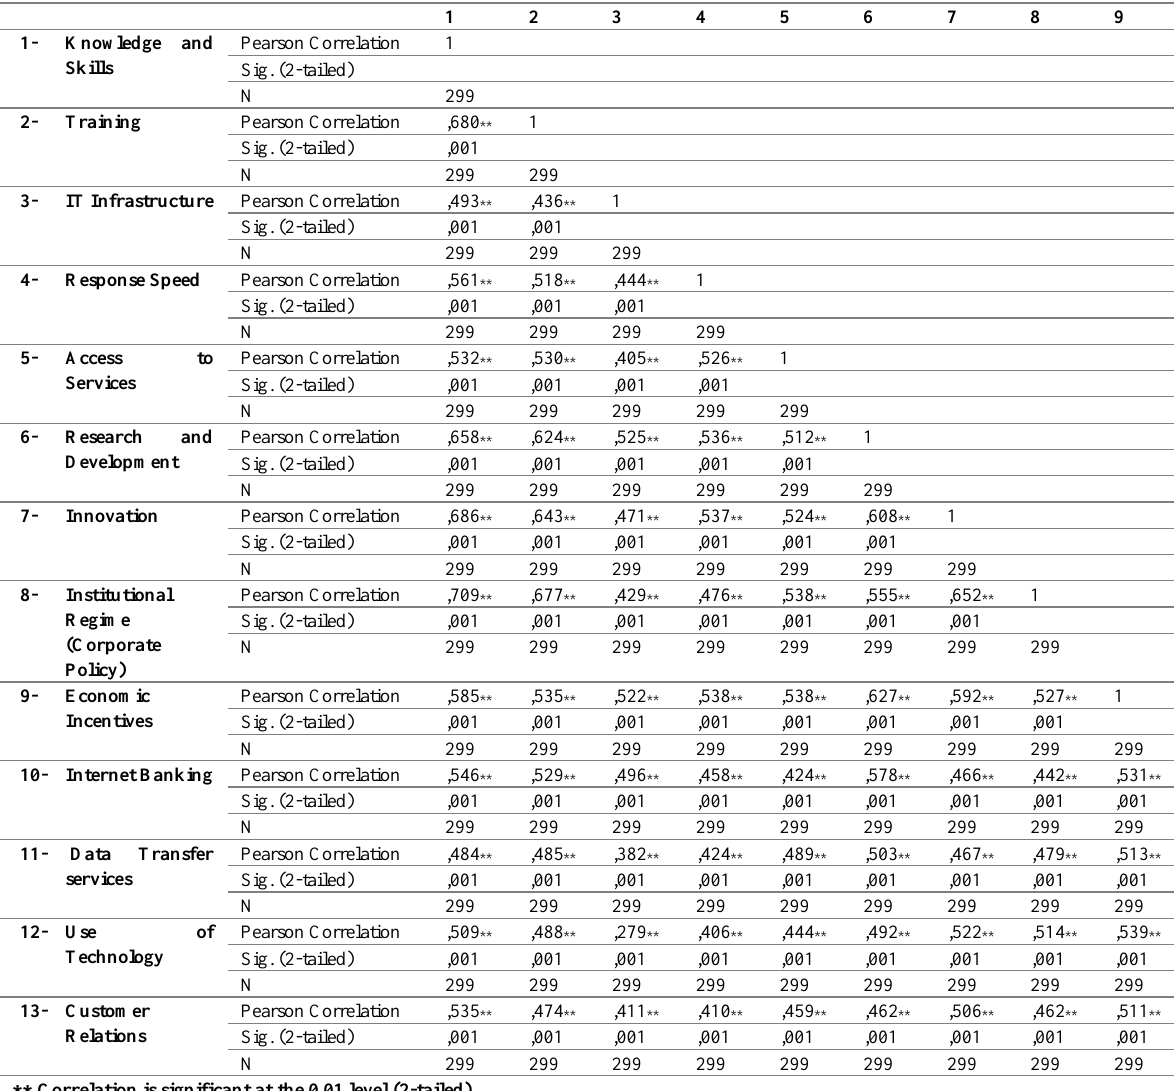
Table 3 shows Pearson Correlations between variables of the study. All study variables are positively and significantly correlated. Strong Correlations ranged between .642 and .802, n = 299, p < .01. Hypotheses; H1a, H1b, H1c and H1d are all accepted, therefore, H1 is fully accepted. Table 5: Correlations Between Sub-variables of Knowledge Economy and Sub-variables of The Development of Banking Services